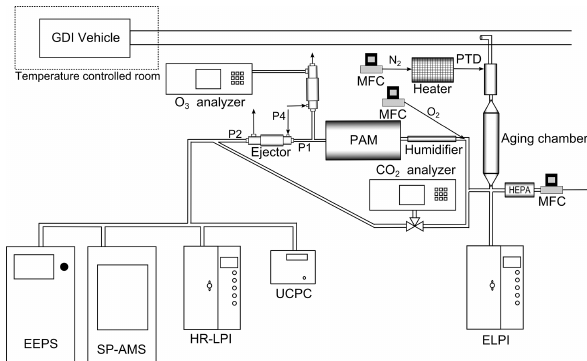
Figure 1. Schematic of the experimental setup (MFC = mass flow